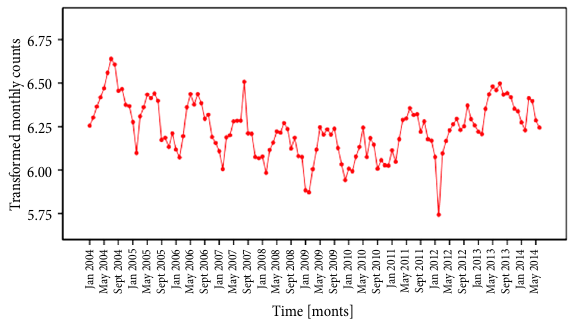
Figure 3. Time series of monthly rail passenger flows in Serbia